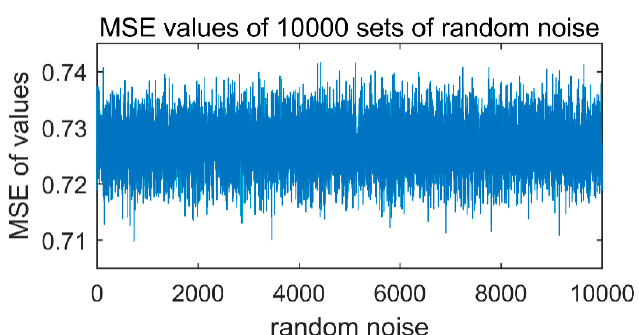
Figure 15. CEEMD decomposes vibration signals. ( a ) Time domain. ( b ) Frequency domain.